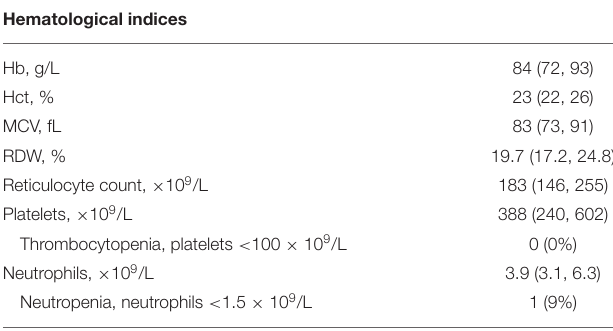
TABLE 1 | Hematological indices of 11 children with sickle cell disease a .